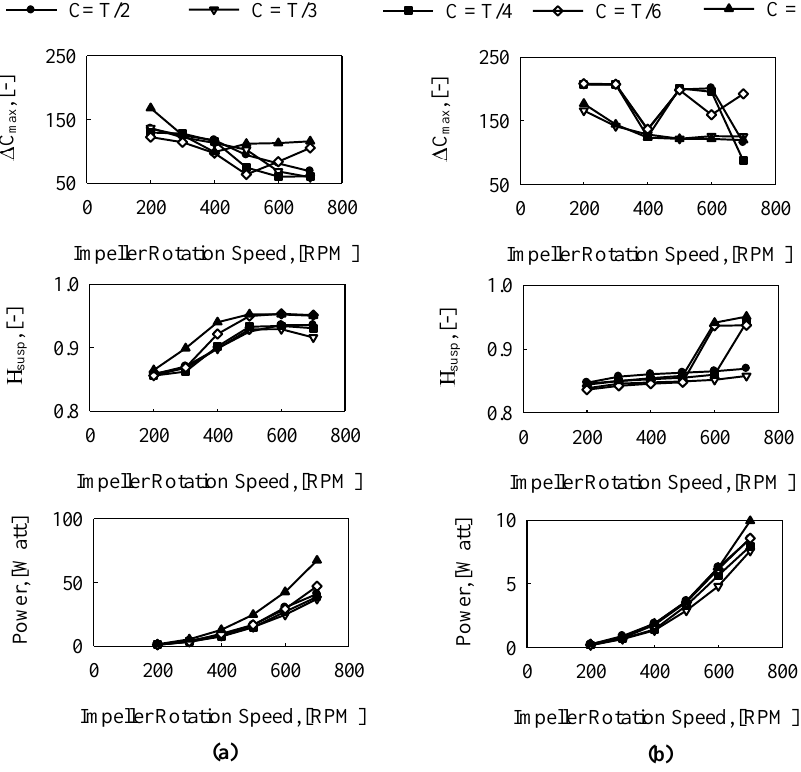
Figure 6. Suspension quality and power consumption plotted at different stirrer speeds and off-bottom clearance for impeller to tank diameter ratio of ( a ) 0.5 and ( b )